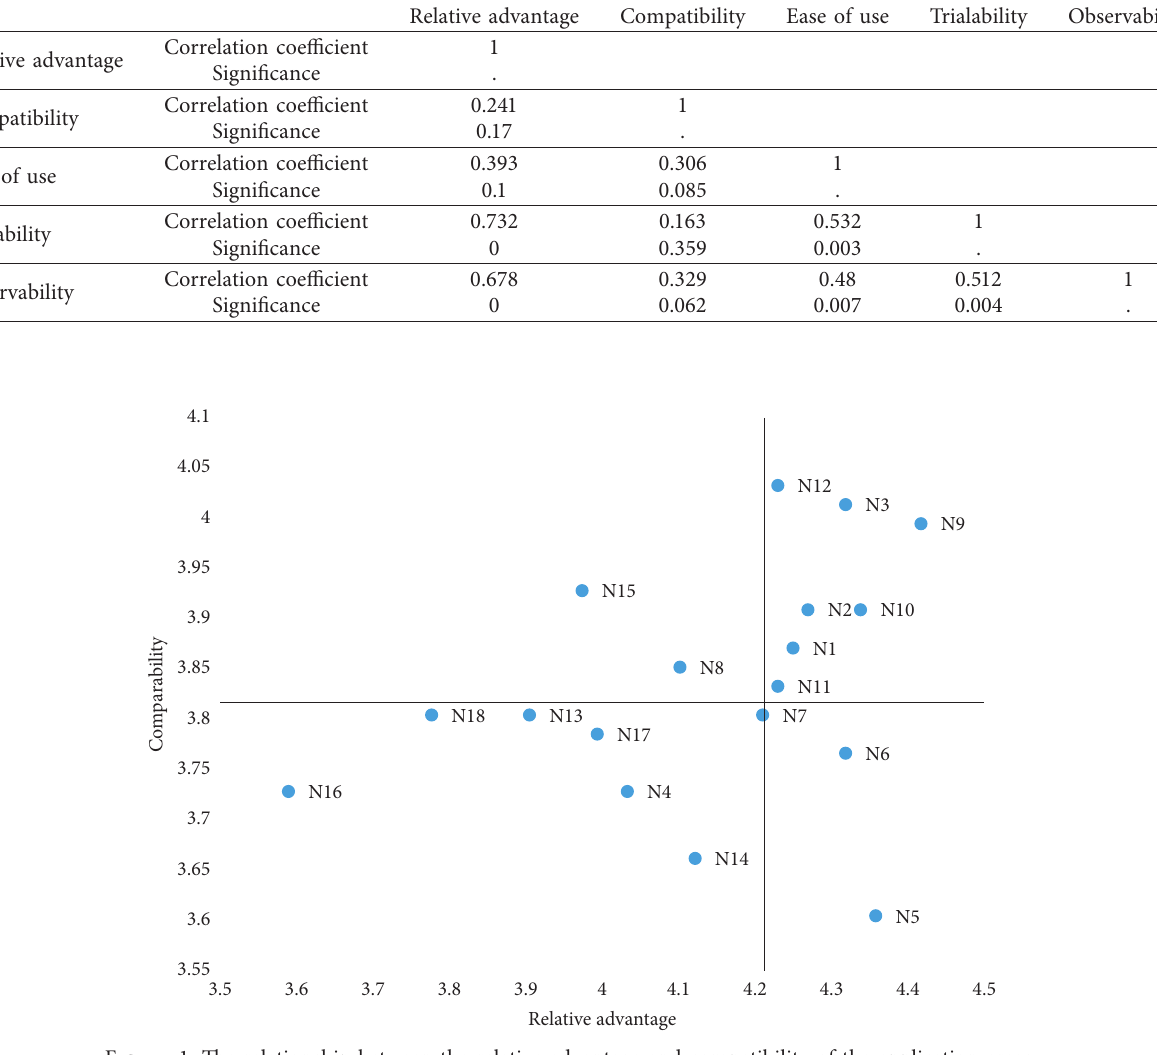
Table 11: The correlation analysis of five attributes.